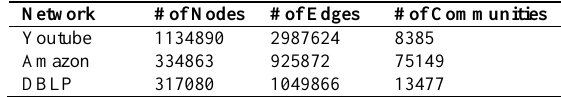
Table 1. Details of large real-world